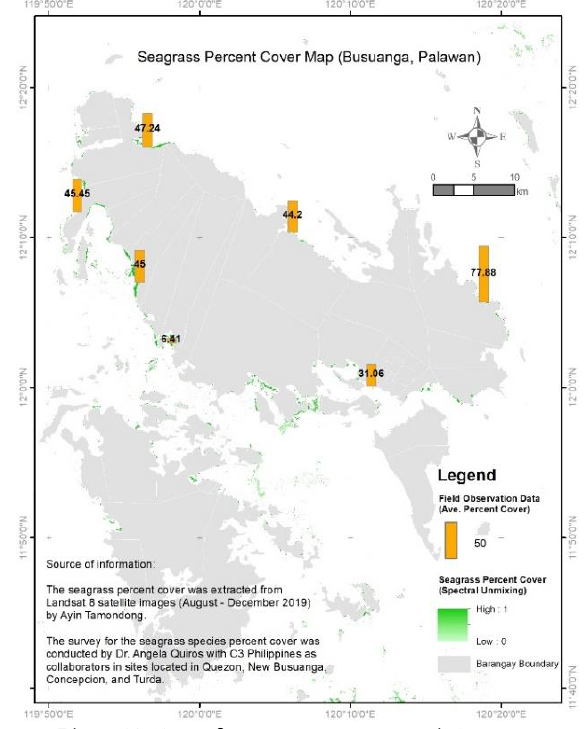
Figure 13. Map of seagrass percent cover in Busuanga To validate the results of the linear spectral unmixing of seagrass percent cover, a correlation analysis was performed using the field survey data. Figure 14 shows the results of the validation indicating an R square of 0.7741.